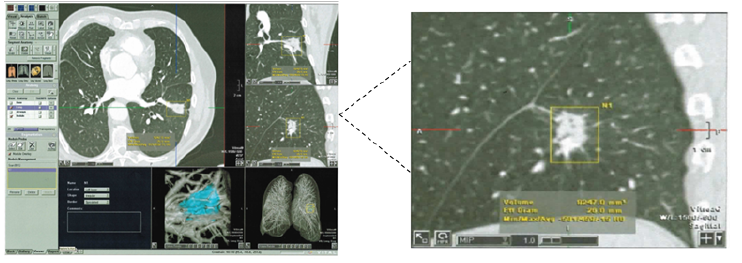
Figure 1. Calculation volume example on magnetic resonance imaging (MRI) medical image by Vitréa